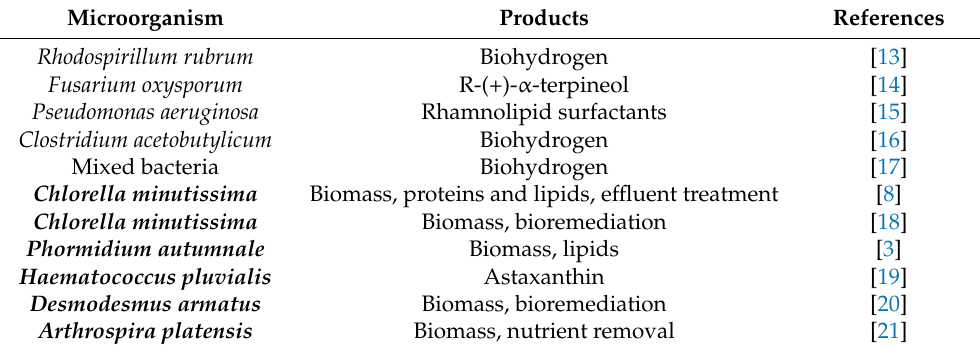
Table 1. Microbial strains cultivated on cassava wastewater for various bioprocesses, the microalgae are presented in bold